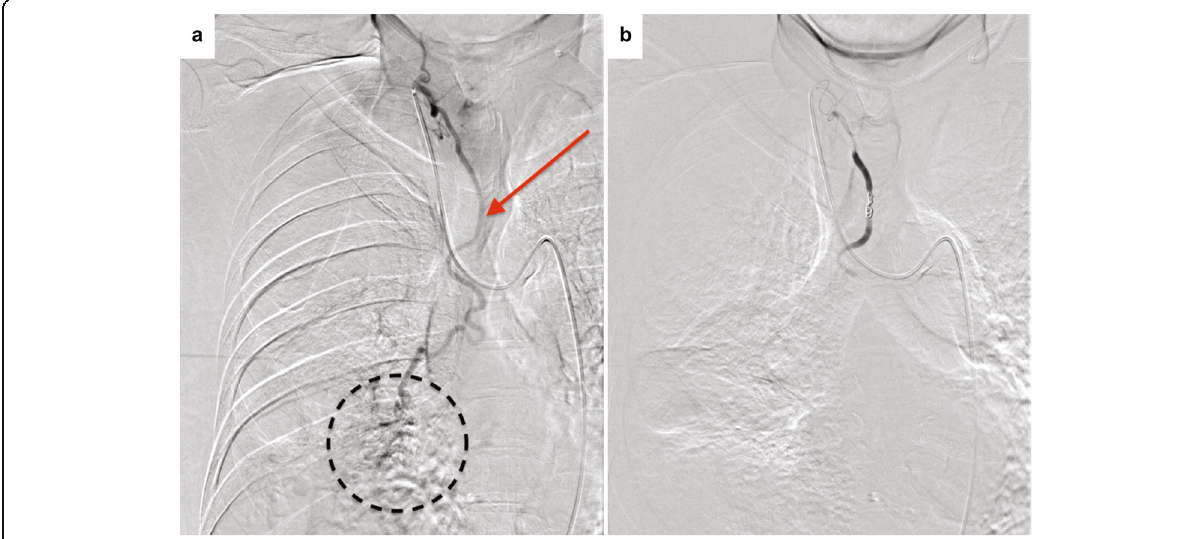
Fig. 4 A Selective angiogram of the ectopic right bronchial artery (arrow) shows parenchymal staining in the right lower lobe (dotted circle). B The parenchymal staining disappeared after embolization with gelatin sponge